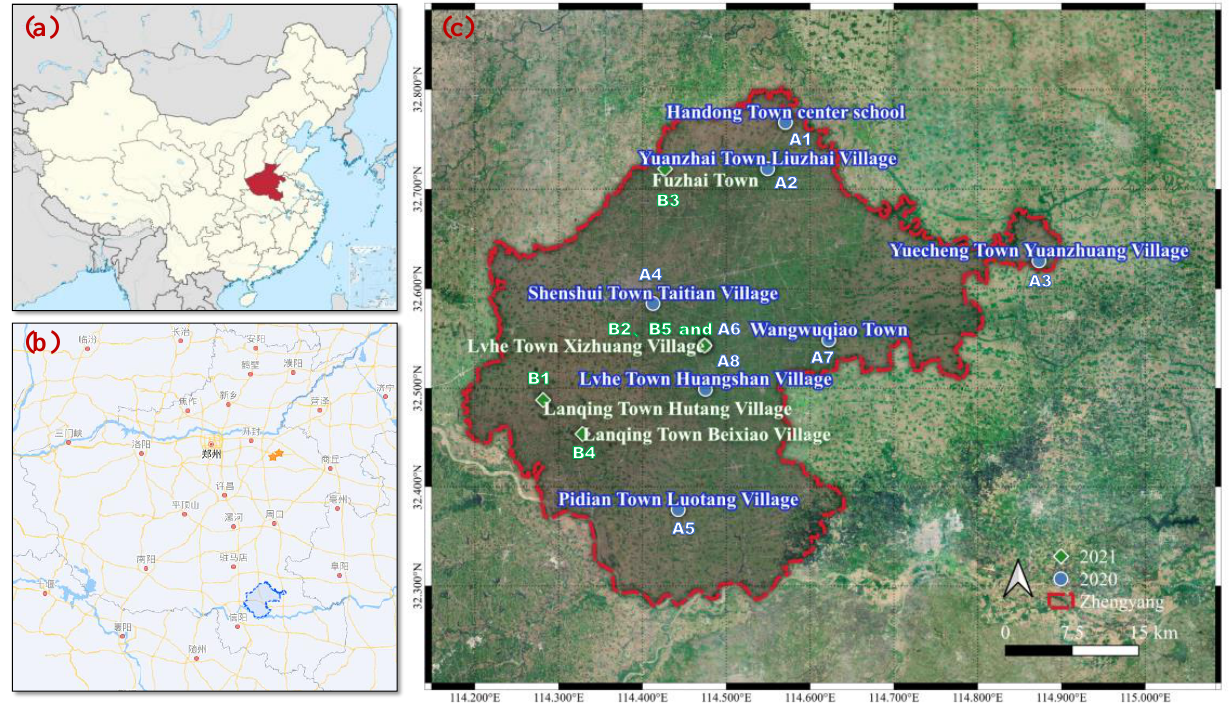
Figure 1. The geographical locations of experimental field sites. ( a ) Henan Province is shown as a red background in the China map; ( b ) the blue border is the Zhengyang County; ( c ) distribution of experimental field sites in the Zhengyang County.